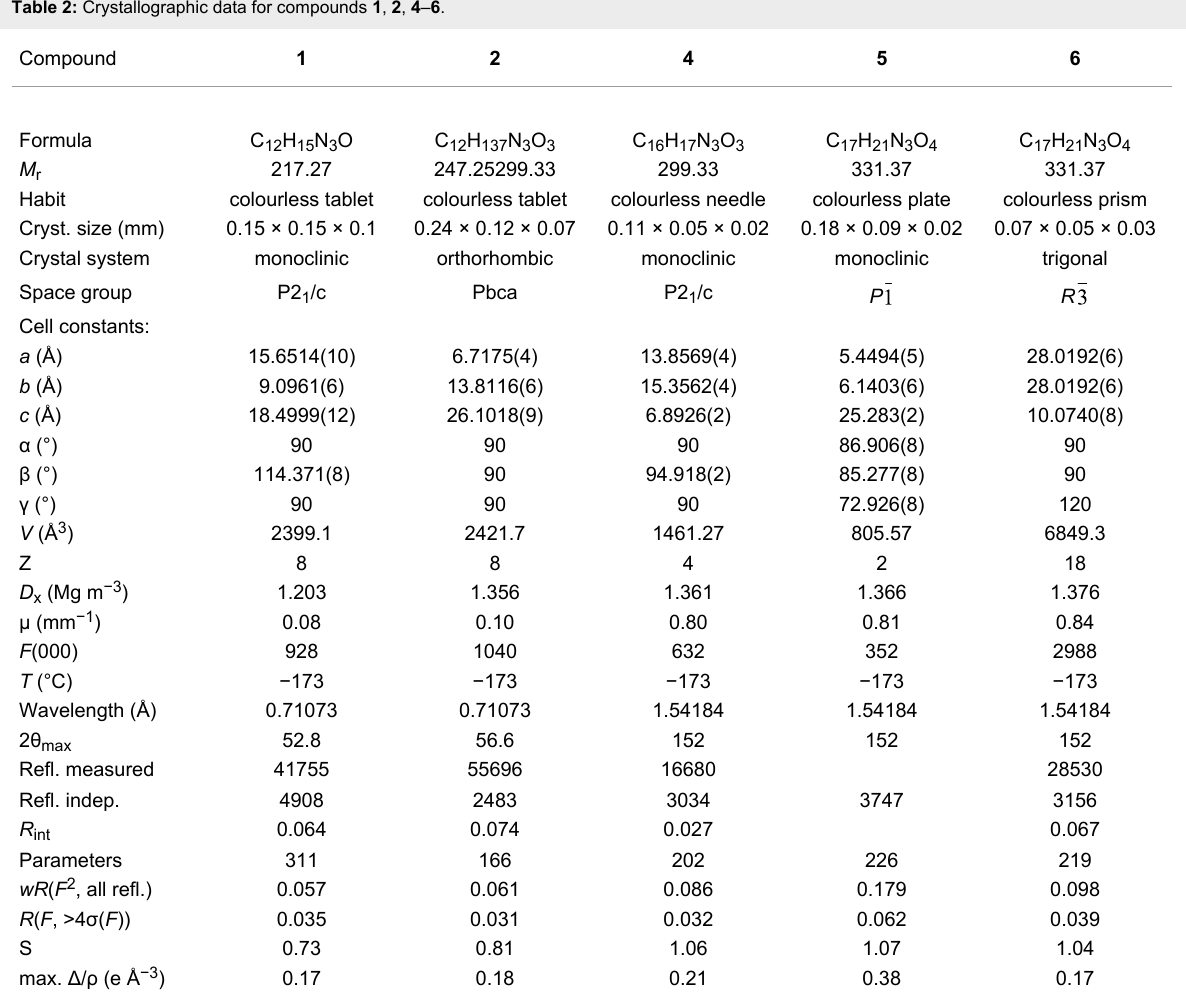
Table 2: Crystallographic data for compounds 1 , 2 , 4 – 6